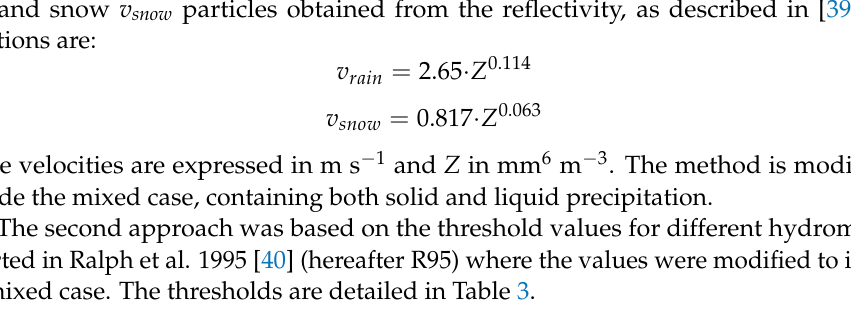
Table 3. Precipitation type adapted from A73 and R95.